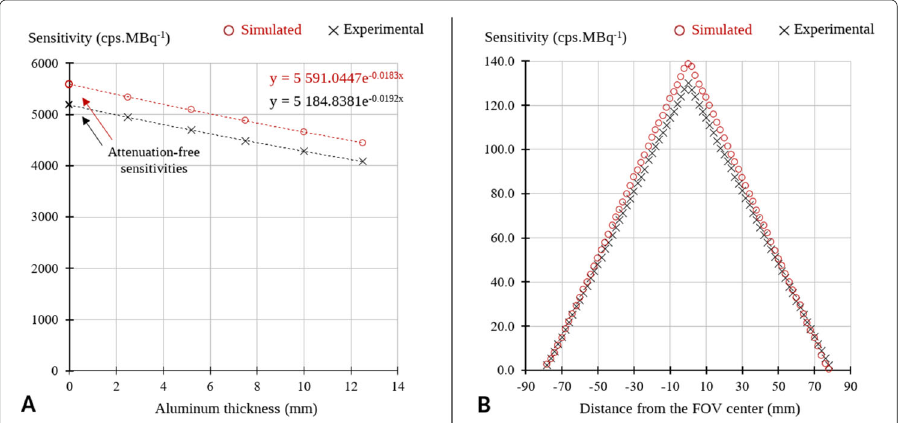
Fig. 5 a Total count sensitivities measured according to NEMA standards for simulated and experimental data, for increasing thicknesses of aluminum sleeves and with the exponential regressions providing attenuation-free count sensitivities. b Sensitivities of contiguous axial slices according to the distances from camera centers